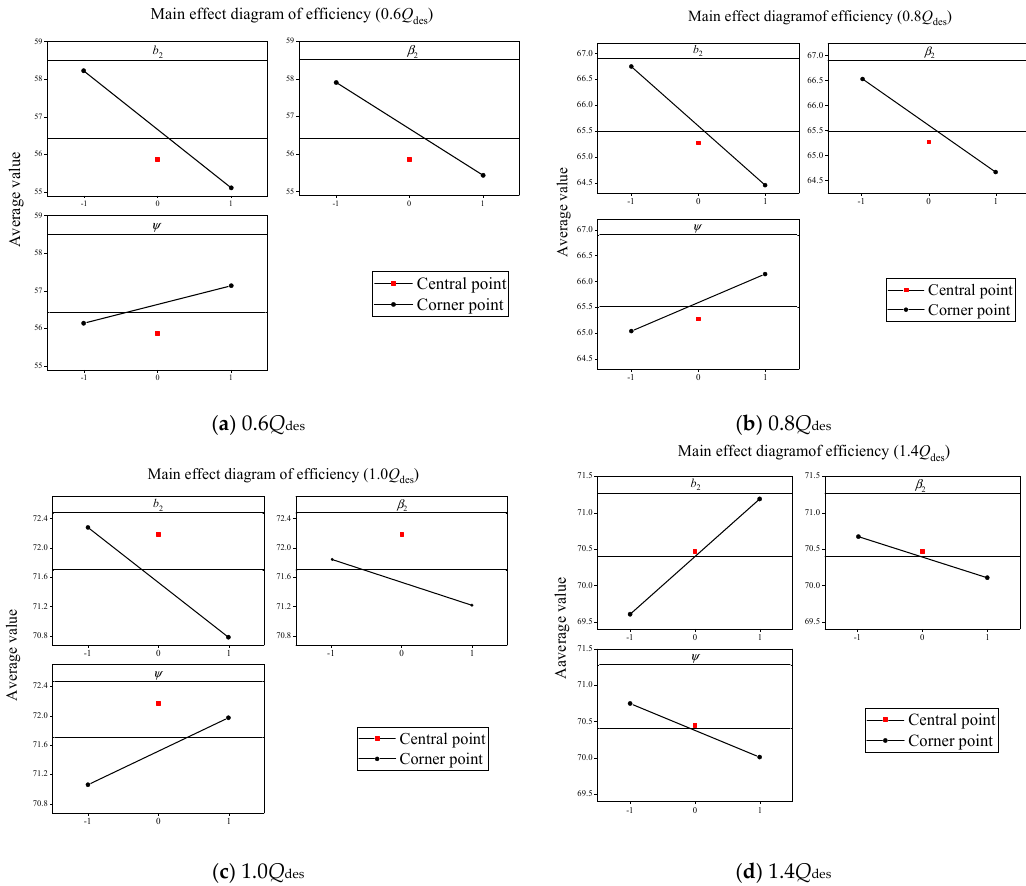
Figure 9. Main effects diagram of different operation conditions. Figure 9. Main e ff ects diagram of di ff erent operation